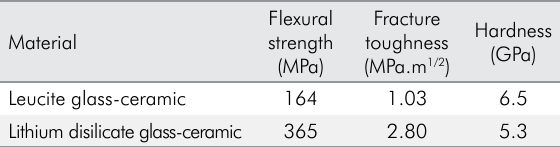
Table 1. Mechanical properties for the traditional glass-